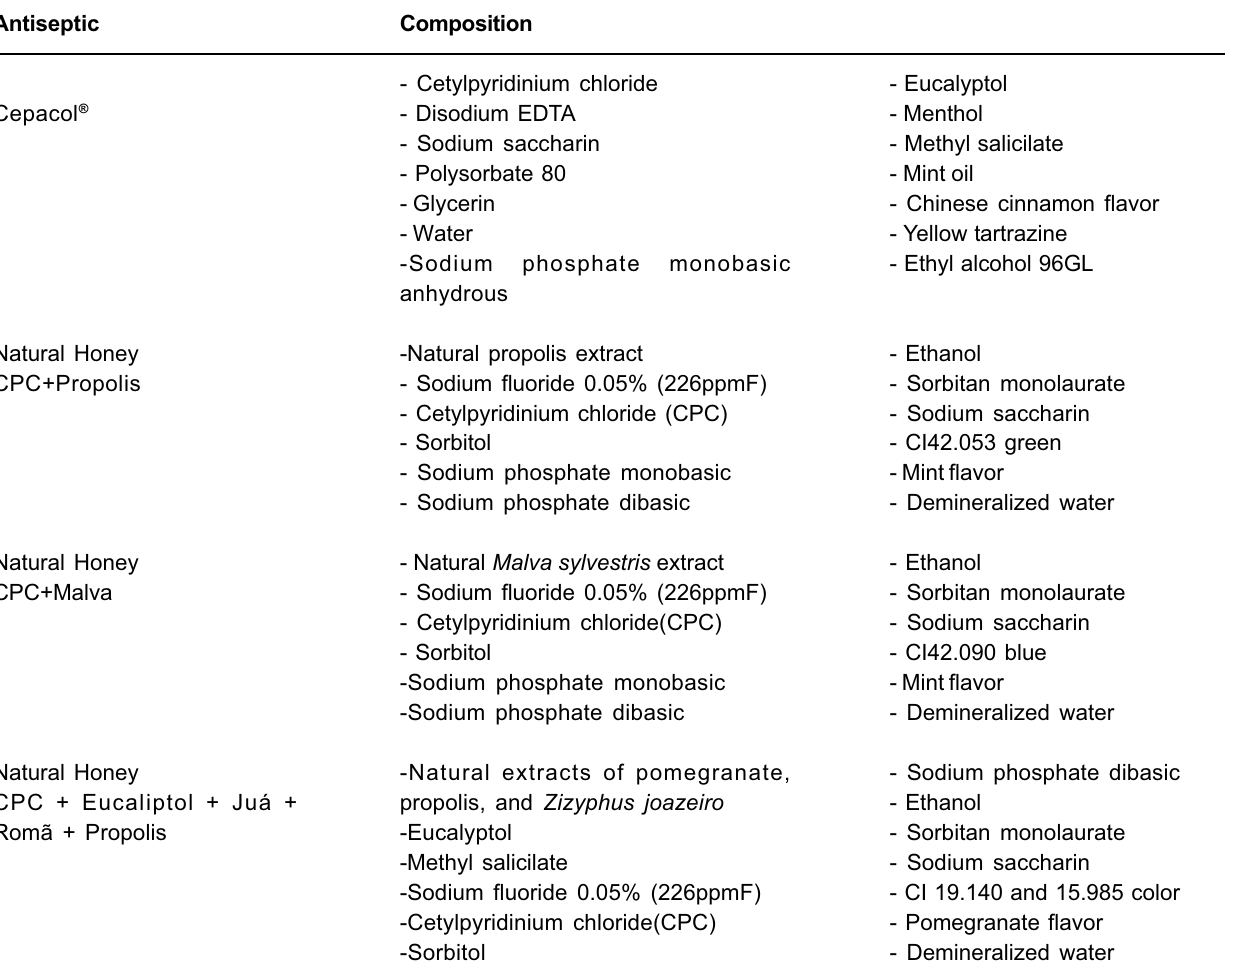
TABLE 1- Chemical composition of the antiseptic solutions